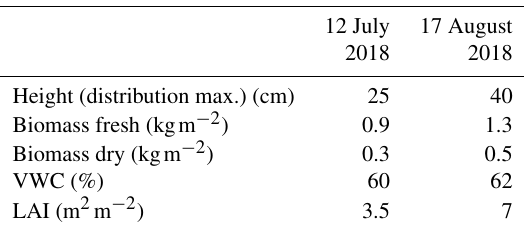
Table A2. Measured vegetation parameters at the Maqu site during summer 2018. Vegetation water content (VWC) is gravimetric: kilogram of water per kilogram of fresh